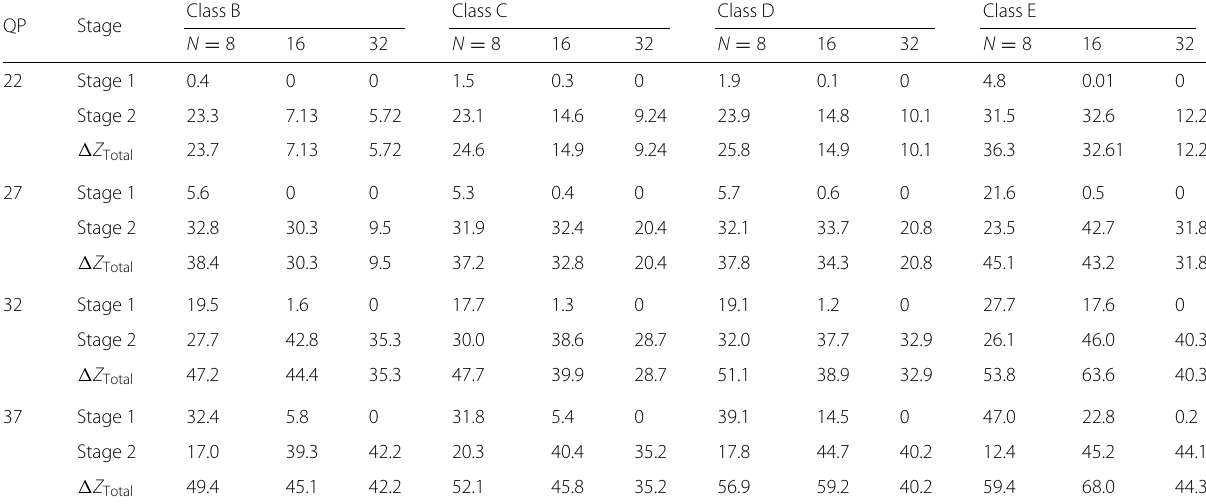
Table 6 Resulting (cid:7) Z (%) values when employing the method proposed by Sousa [9] in the first stage QP